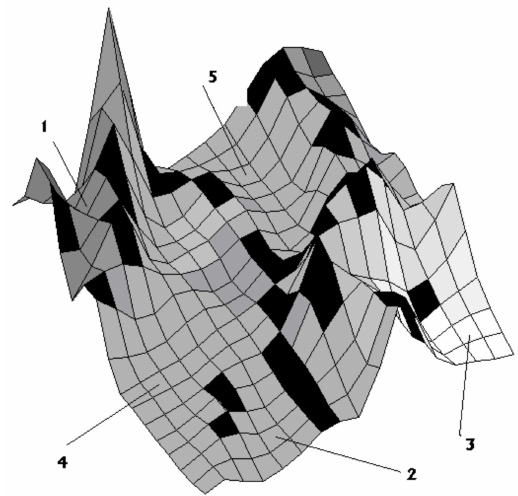
Figure 3. Visualization of a state space landscape with five basins (1–5; areas in the state space) of